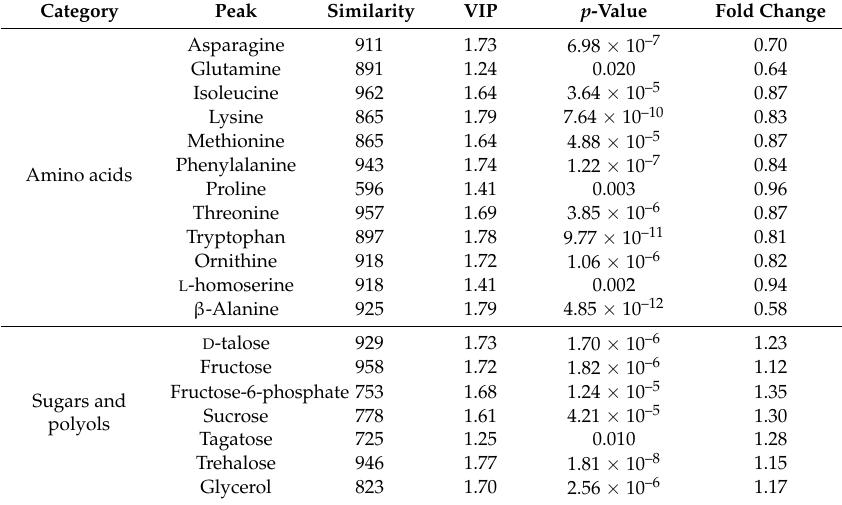
Table 4. Major metabolite changes in SRBSDV-infected WBPH under cold stress. By GC-TOF-MS analyses of six biological replicates of cold-stressed and unstressed virus-carrying WBPH, the metabolites that had a VIP > 1.0 and p -value < 0.05 were considered to be significantly altered metabolites, and amino acids, sugars, and polyols were selected to show in the table. Category Peak